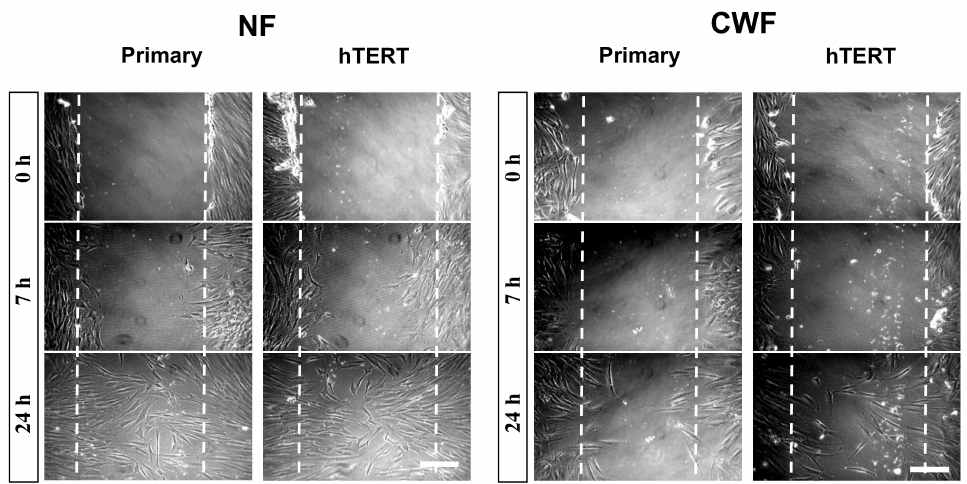
Figure 3. Utilising a monolayer wound scratch assay and time lapse microscopic analysis immortalised NF, like the primary cells from which they were established, clearly repopulated the wound space over a period of 24 h whereas the patient-matched CWF cells (both primary and immortalised) failed to do so. Scale bar = 100 µ